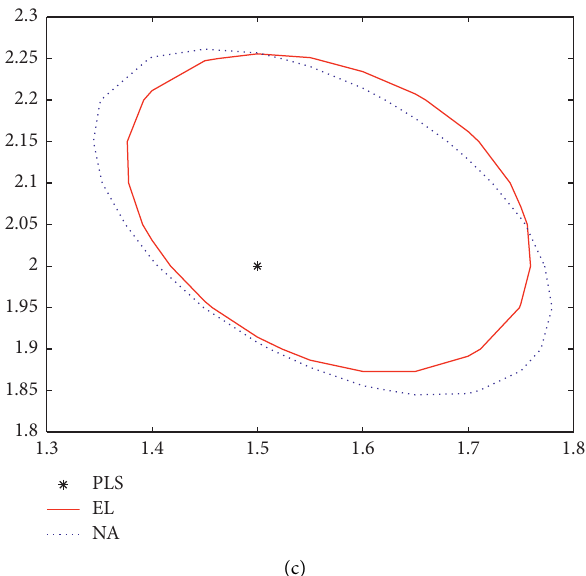
Figure 1: 95% confidence regions for ( β